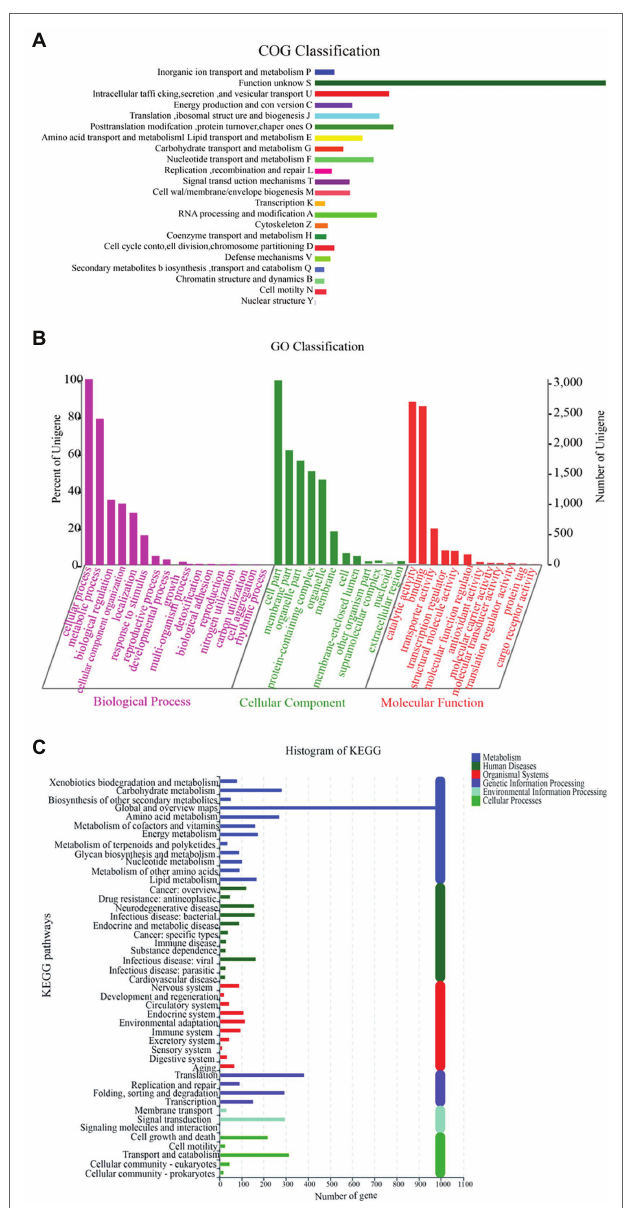
FIGURE 4 | Diagram of COG function annotation analysis (A) ; Diagram of GO/IPR function annotation analysis (B) ; and Diagram of KEGG function annotation analysis (C)